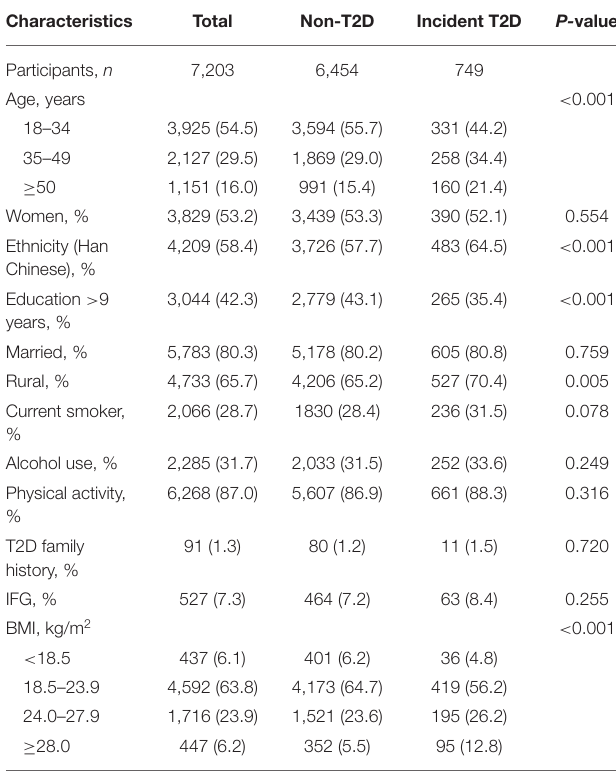
TABLE 1 | Baseline characteristics among participants in Southwest